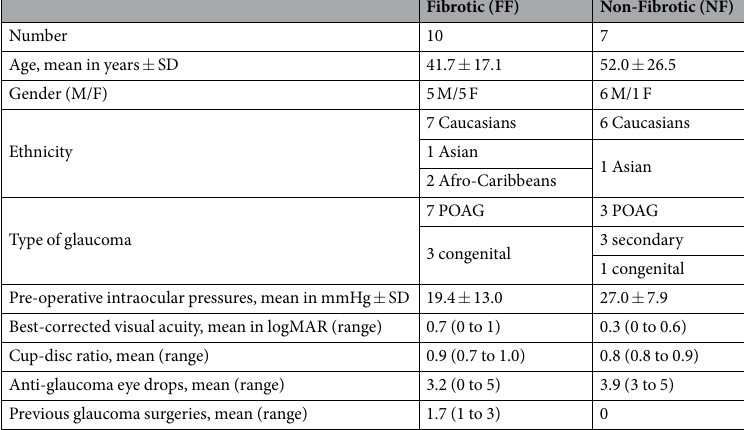
Table 1. Patient demographics for the FF and NF